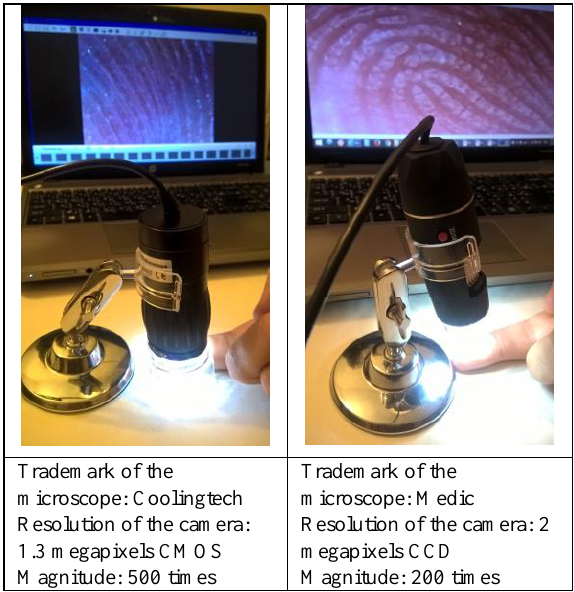
Figure 1. Hand microscopes used in the research and their specifications